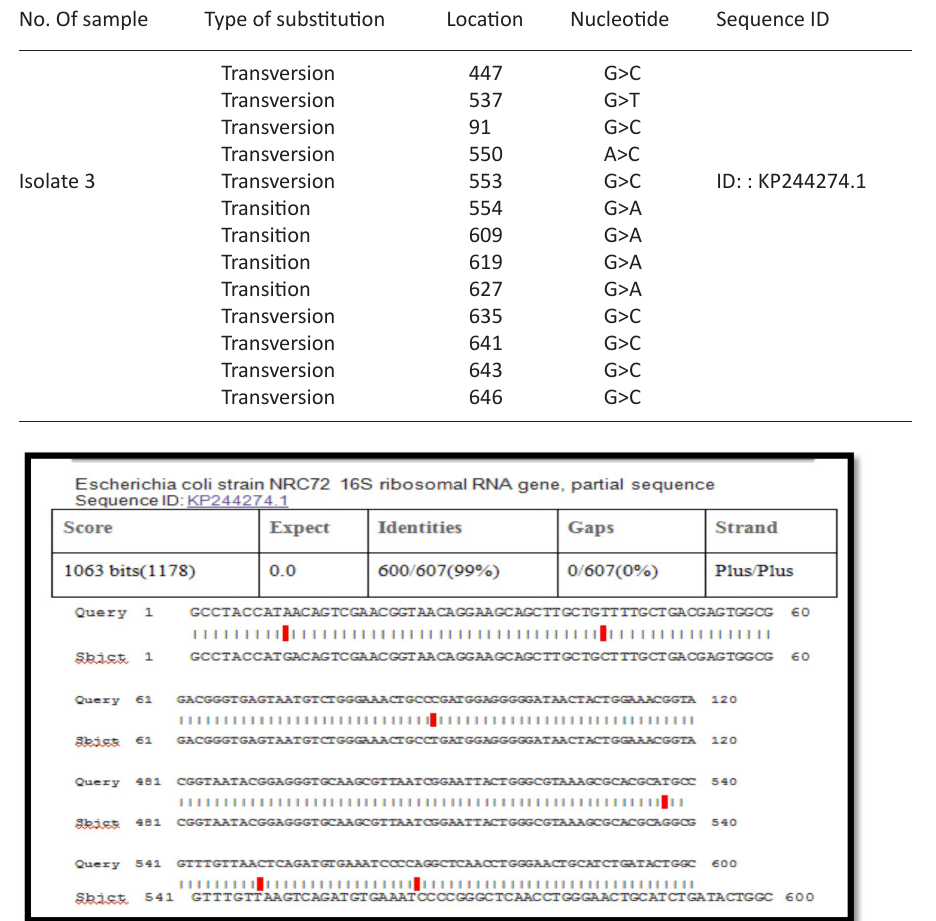
Fig. 5. Sequence analysis of 16S rRNA gene for E.coli isolate